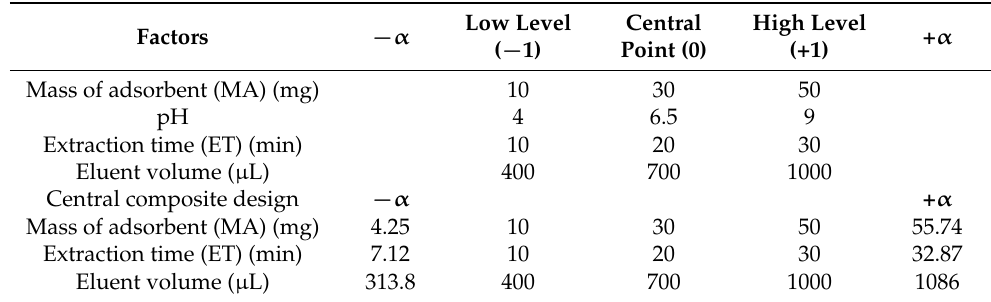
Table 1. Parameter and levels used in 2 4 − 1 fractional factorial design and central composite design. Factors −